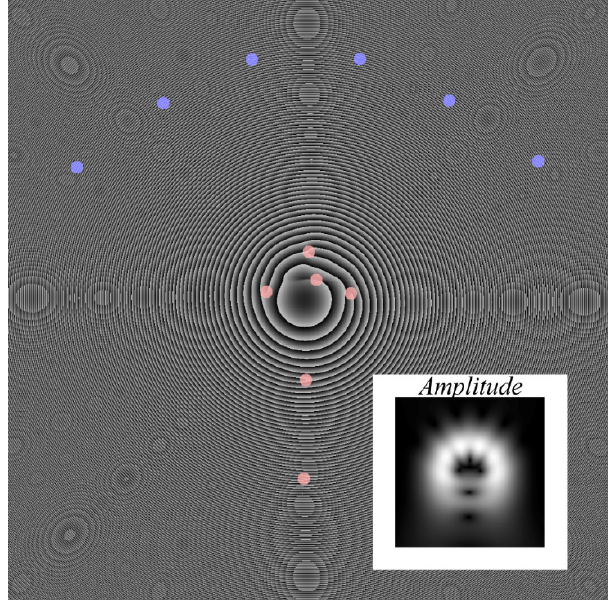
Figure 7. An amplitude (inset), phase at a distance of z = 200 μ m. Positive dislocations are purple shaded circles and negative ones are within cyan shaded circles. Both amplitude and phase field sizes are 288 × 288 μ m.